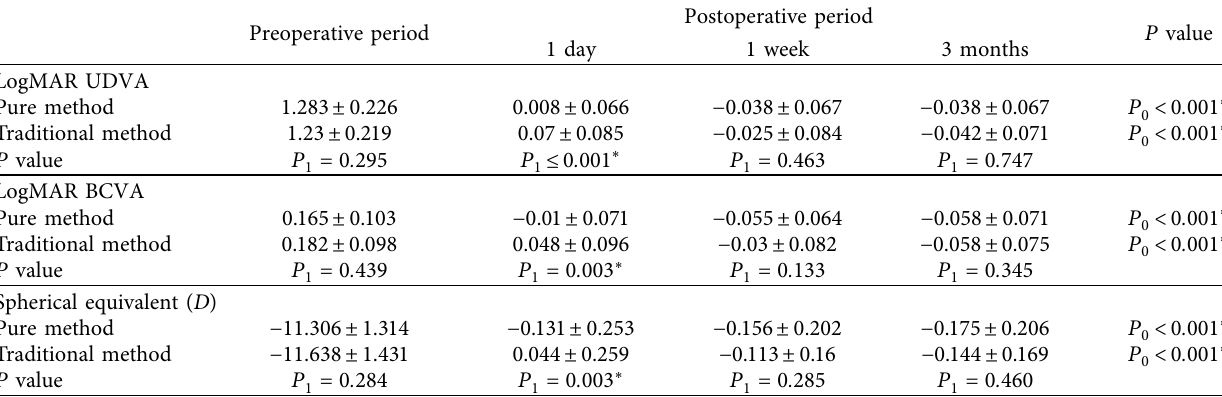
Table 2: Time courses of the visual and refractive outcomes between the pure ICL implantation and the traditional ICL implantation groups.